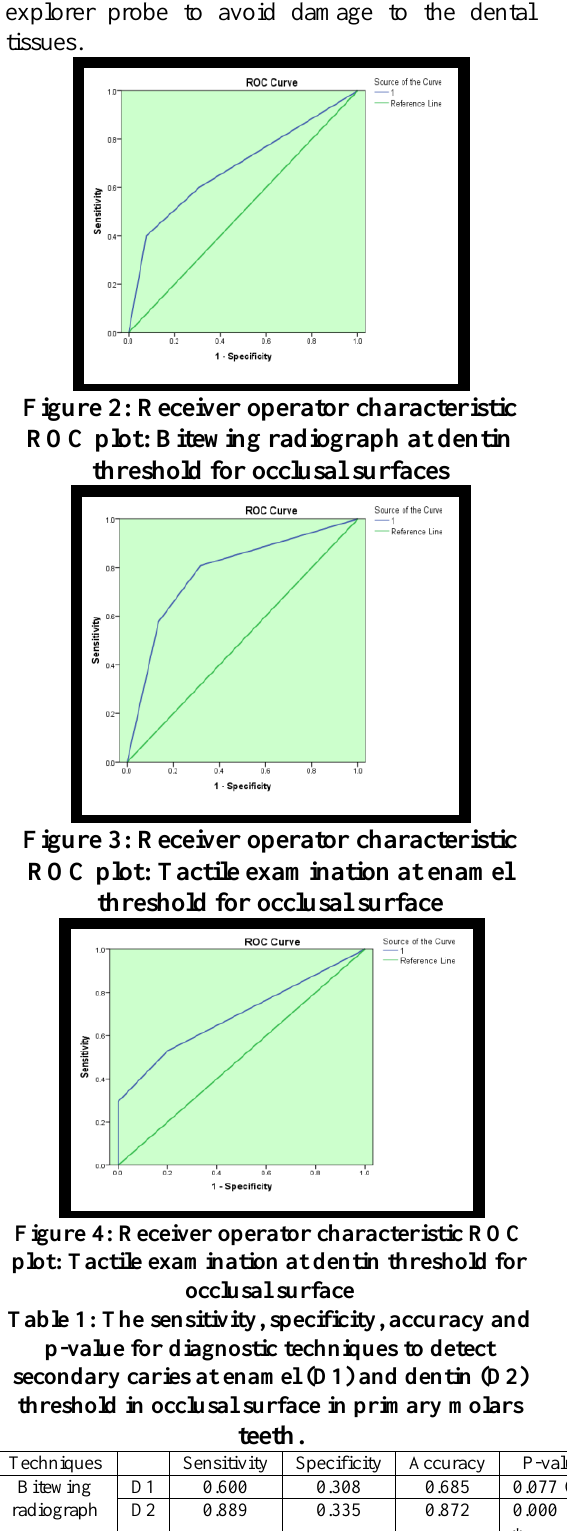
Figure 1: Receiver operator characteristic ROC plot: Bitewing radiograph at enamel threshold for occlusal surfaces